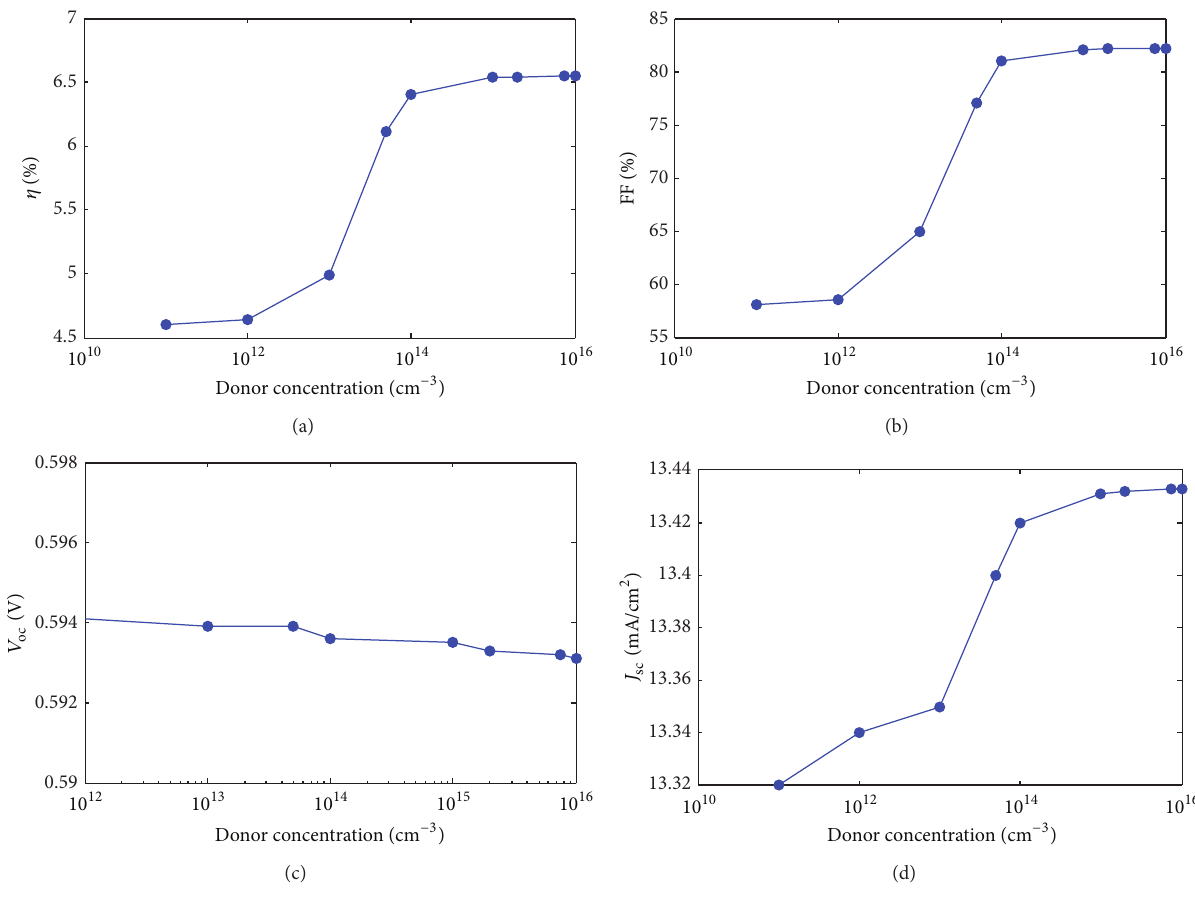
Figure 5: The effect of donor concentration, ( n ) in the GaAs n-type layer, on the performance parameters with an optimum value of about 10 16 cm −3